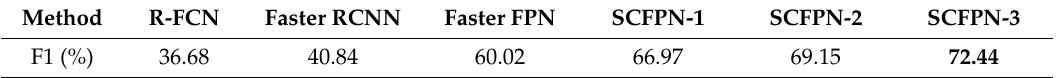
Table 4. Comparison of the F1 results. The bold result is the best performance value.